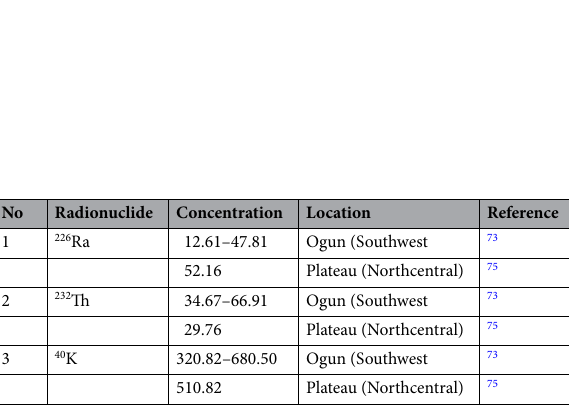
Table 6. Radionuclide contents in atmospheric dust in selected parts of the study